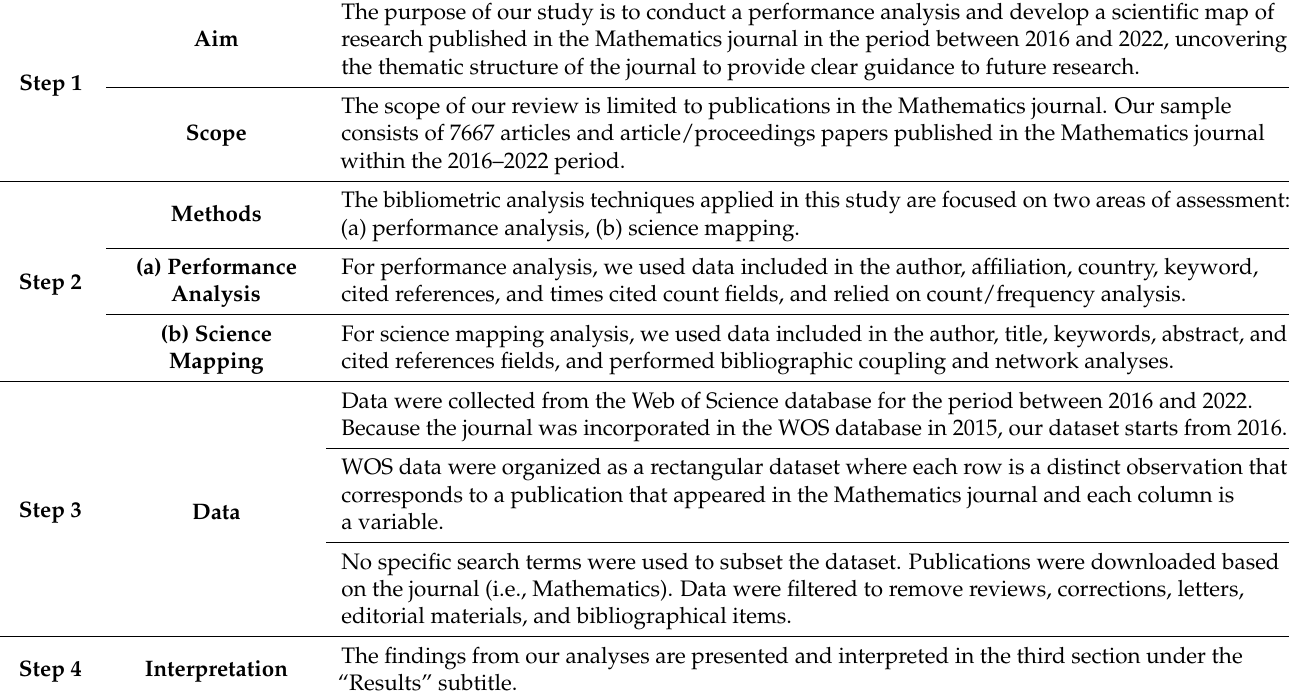
Table 1. Major steps of the bibliometric